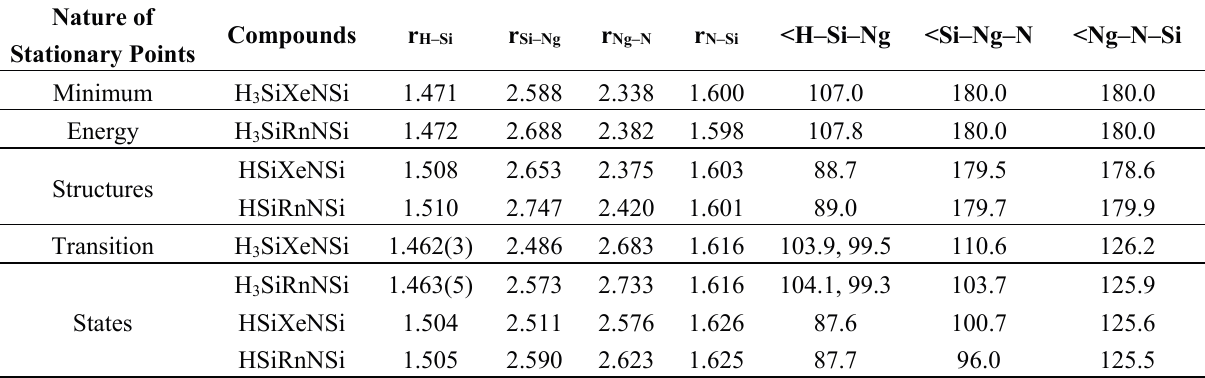
Figure 1. Pictorial depictions of the energy minimum structures and the transition states (TSs) of H 3 SiNSi, HSiNSi, H 3 SiNgNSi and HSiNgNSi compounds. Point groups along with their electronic states are given in parentheses. TS-1 and TS-2 are associated with the dissociation of H 3 SiNgNSi and HSiNgNSi, producing Ng and H 3 SiNSi or HSiNSi. Table 1. The geometrical parameters (in Å and degrees) of the optimized geometries of H 3 SiNgNSi and HSiNgNSi compounds (both minimum energy structures and transition states) studied at the MP2/def2-QZVPPD